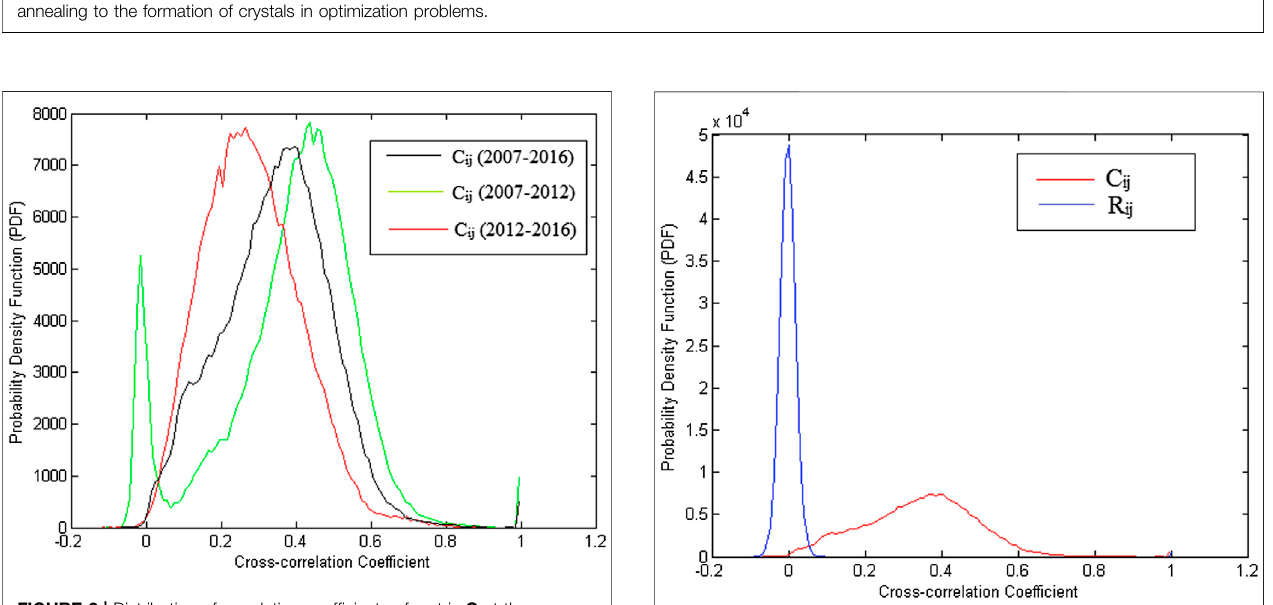
FIGURE 3 | The Probability Density Function (PDF) of the correlation coef fi cient C matrix and the R matrix. The red color shows the distribution of the C matrix, and the blue one indicates the distribution of the R matrix on the S&P 500 daily stock price data for the period of January 1, 2007 until October 28, 2016. It clearly shows the different distribution groups separately for the correlation coef fi cient C matrix and R